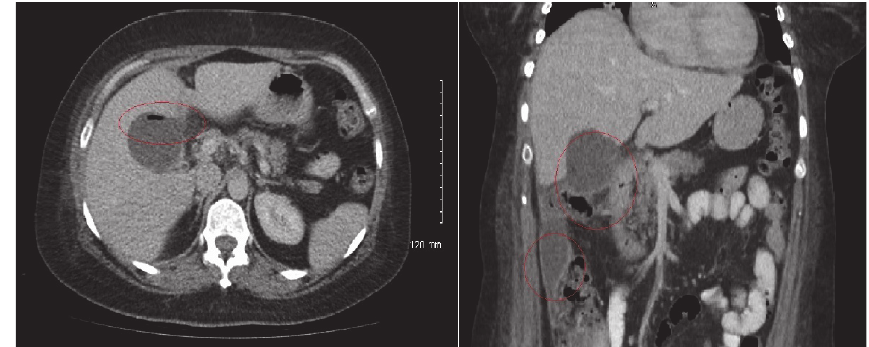
Figure 2: CT abdomen pelvis day 6: air within a distended gall bladder with persistent pericholecystic fat stranding, more marked than on prior imaging and extending to involve the hepatic flexure. New, peripherally enhancing fluid collection extending the inferior tip of the liver along the right paracolic gutter; appearances are suggestive of complicated cholecystitis with a gallbladder